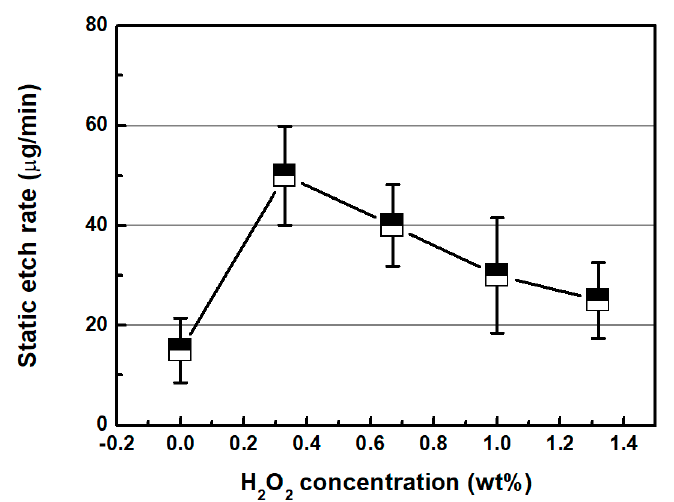
Figure 7. Static etch rate as a function of H 2 O 2 concentration (oxalic acid concentration: 0.2 wt %).